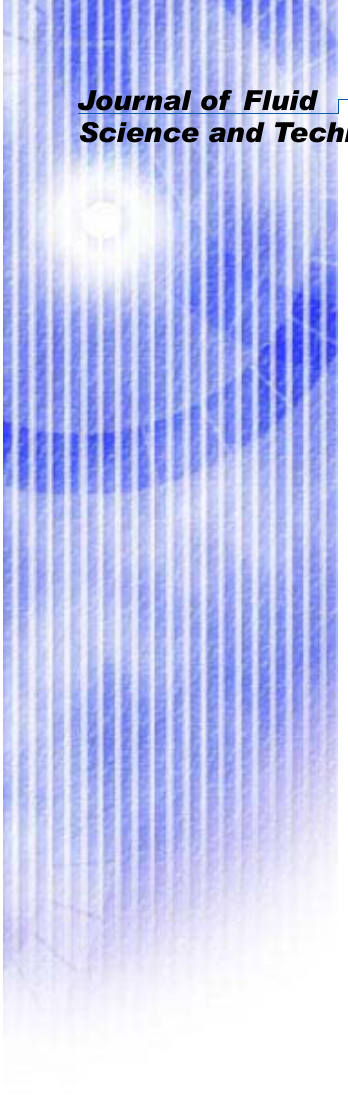
, l and (b) δ , θ under the condition of R = 0.67 and Re u ω